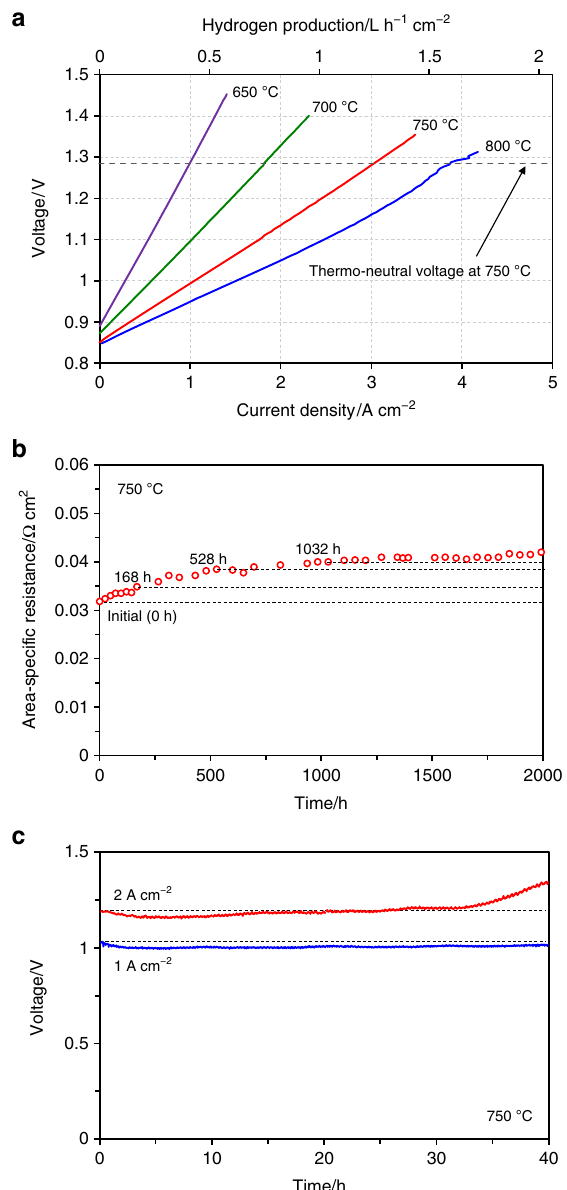
Fig. 5 Electrochemical performance of optimized nanocomposite electrode. The highest performance SSC-SDC(50:50) nanocomposite electrode among our nanocomposite electrodes was evaluated. a I – V characteristics and corresponding hydrogen production for the SOEC at 650 – 800 °C under 50% humidity condition. b ASR of electrode polarization using a symmetrical cell at 750 °C in air under open-circuit condition as a function of operating time for 2000 h. c Short-term durability for the SOEC under electrolysis operating condition. Time-dependent voltage was measured at 750 °C under 40% humidity condition at constant current densities of